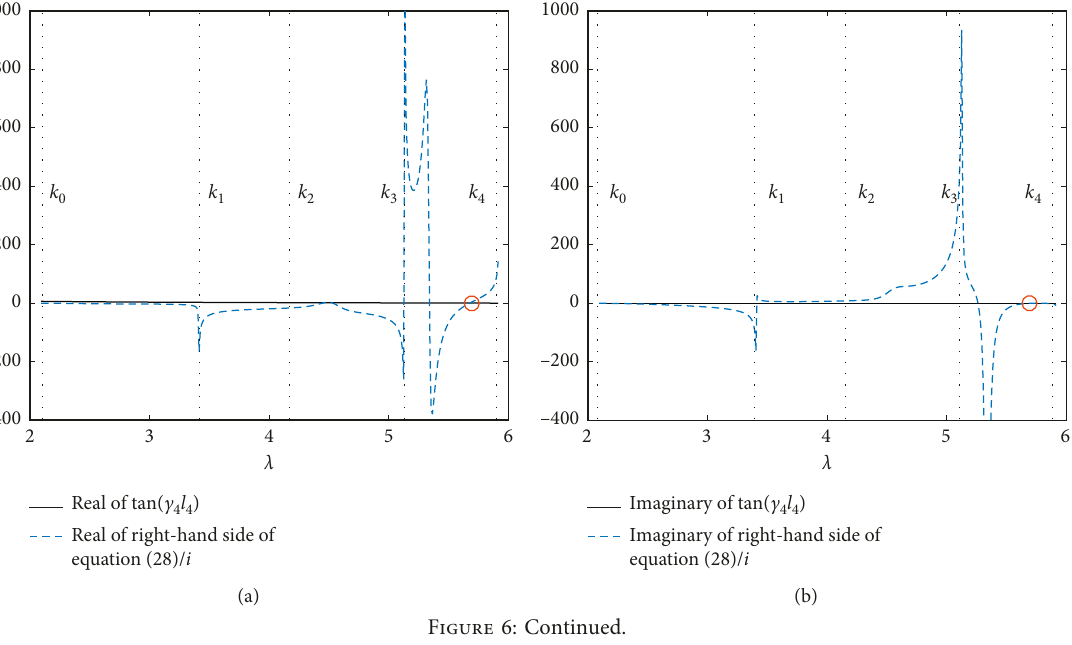
l � 0 . 45 π ; (d) N � 5, k i i